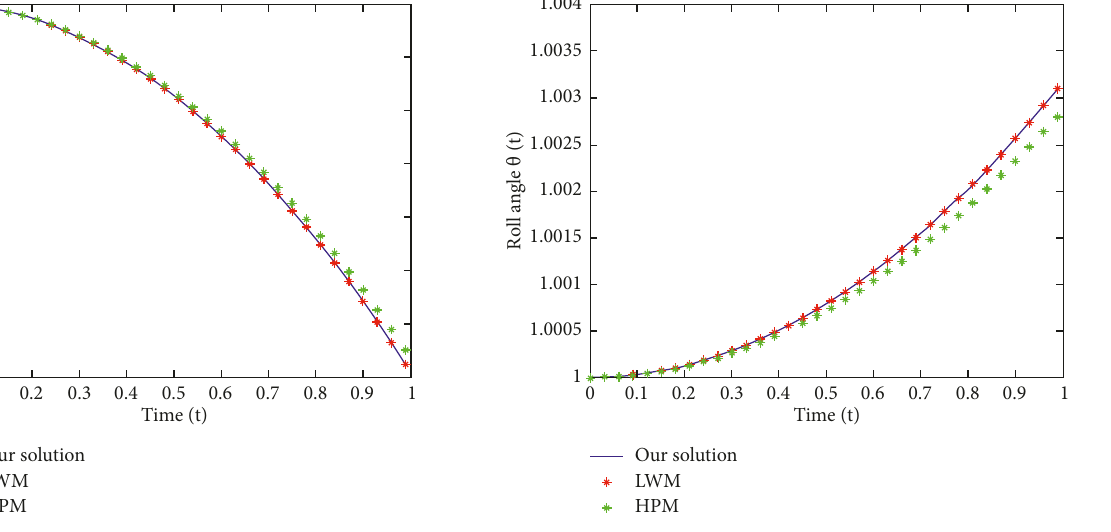
Figure 3: Comparative study of Genocchi polynomial, LWM, and HPM for roll angle with respect to the time t values (in sec) for Ex.3.